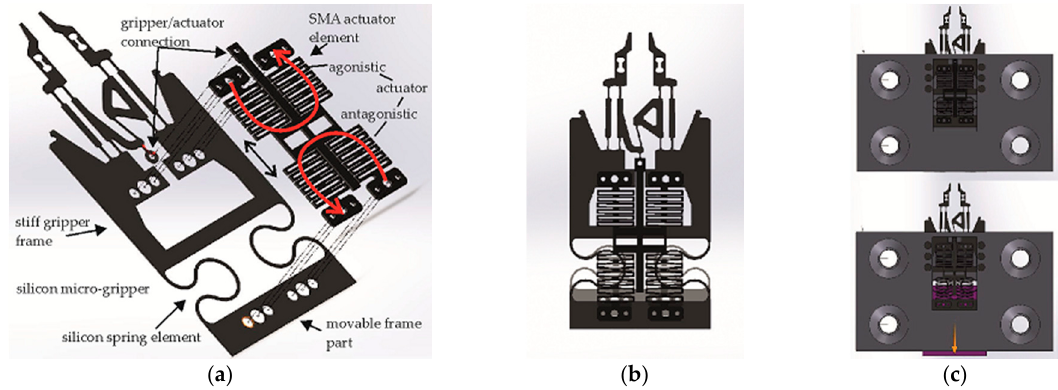
Figure 1. ( a ) Novel micro-gripper with silicon spring element for SMA actuator activation; ( b ) deflection of the flexible micro-gripper part; and ( c ) gripper holder with pre-straining